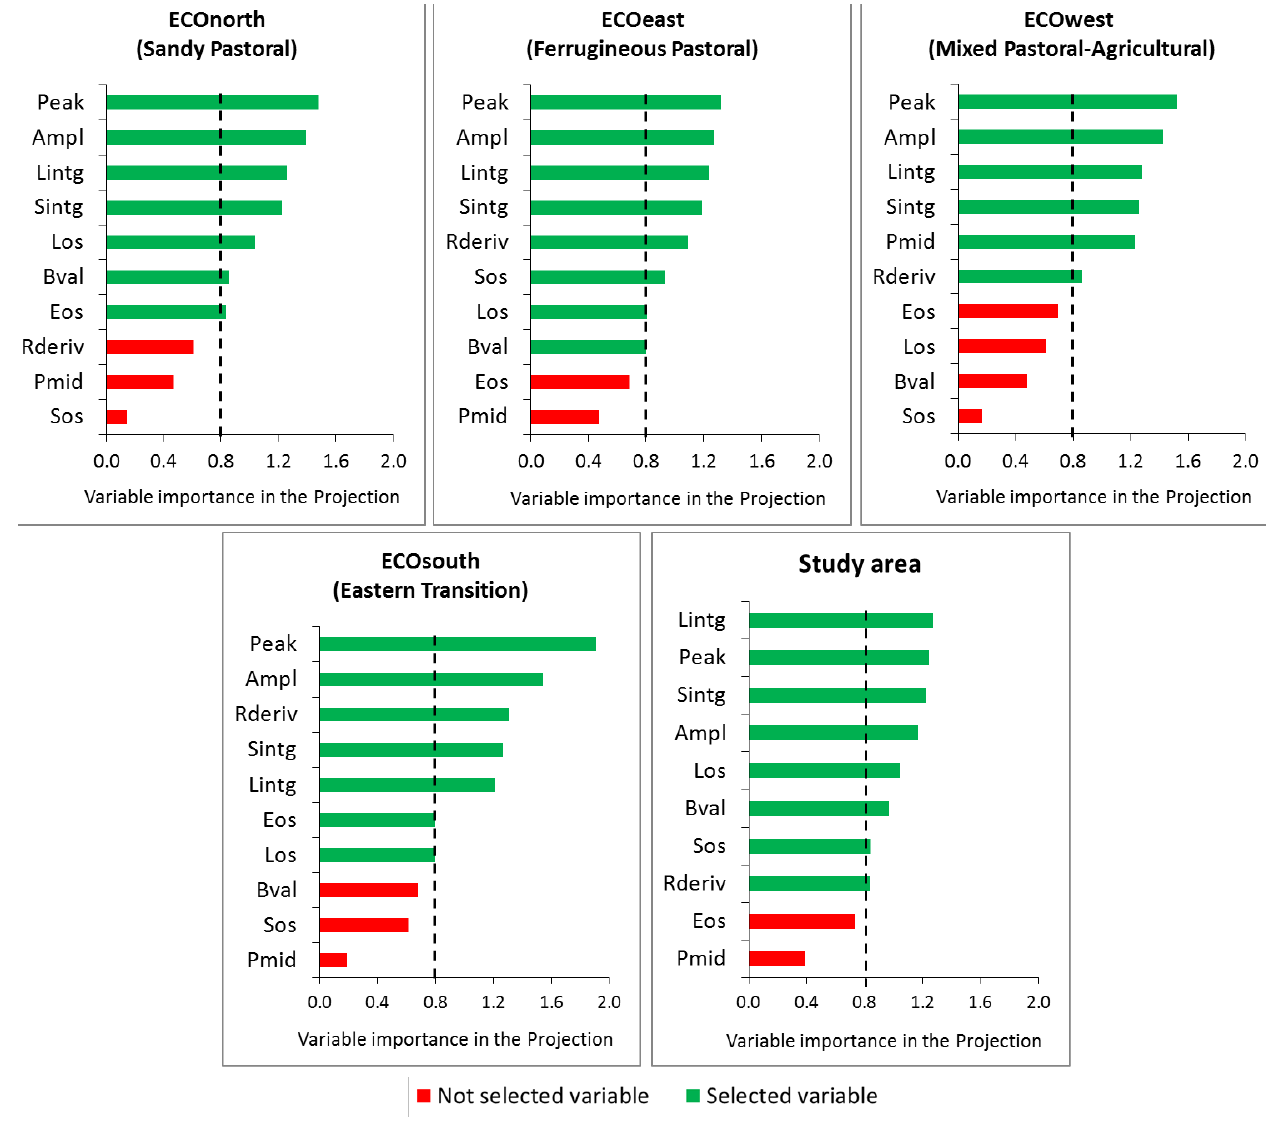
Figure 4. Phenological variable importance for total biomass estimation across ecoregions and for the whole study area. Dashed dark line shows the threshold (VIP = 0.8) for